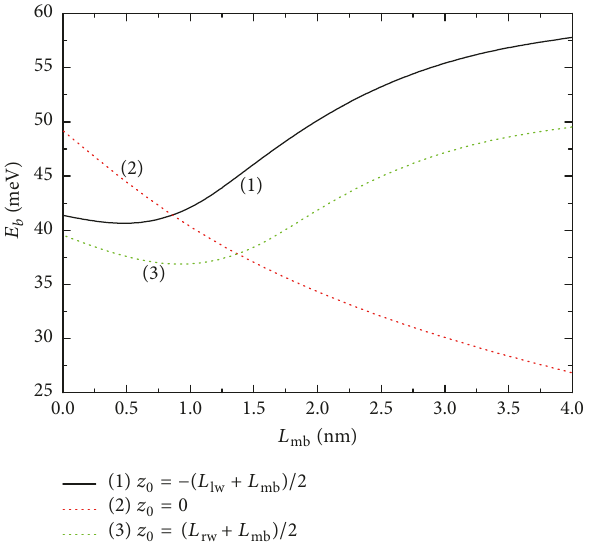
Figure 5: The ground-state donor binding energy 𝐸 𝑏 in a ZB In 𝑥 Ga 1−𝑥 N/GaN symmetric coupled QDs as a function of the electric field 𝐹 for 𝑅 = 10 nm, 𝐿 lw = 4 nm, 𝐿 mb = 1 nm, 𝐿 rw = 4 nm, 𝜌 = 0 .Curves1,2arefortheimpuritypositions 𝑧 0 (𝐿 + 𝐿 )/2 , 0 . rw mb